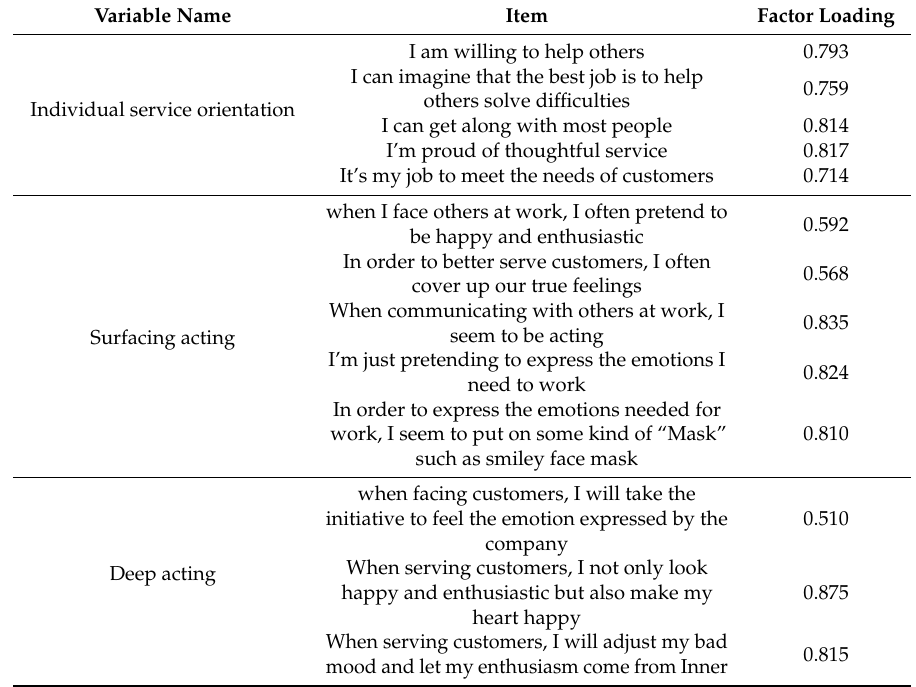
Table 2. Individual service orientation and emotional labor’s convergence validity test.